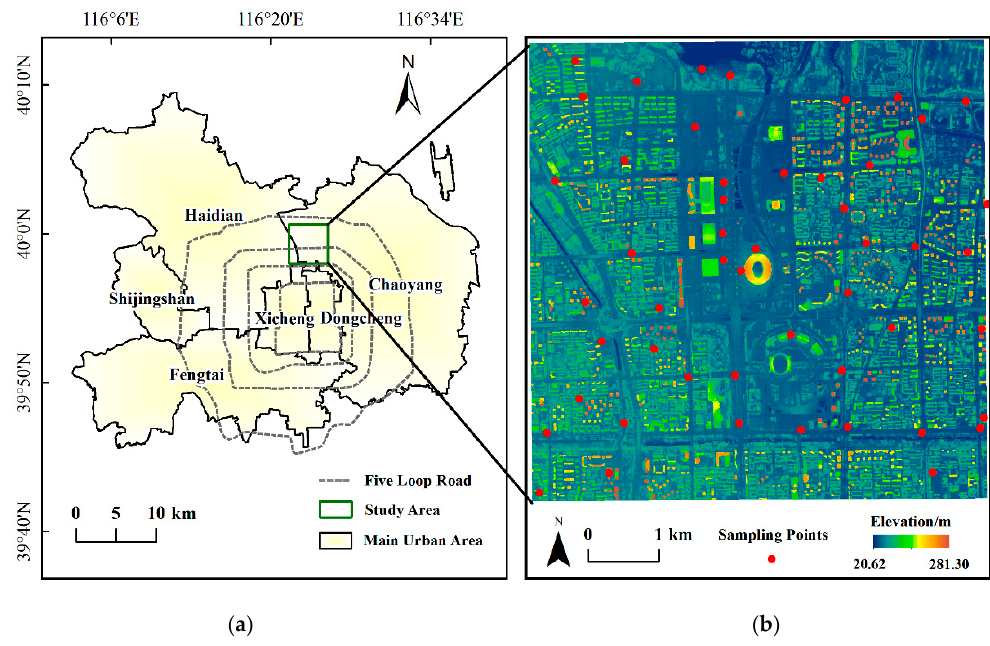
Figure 2. Location of the study area and observation sites. ( a ) Location of the study area in Beijing. ( b ) Digital surface model (DSM) and the location of observation sites.